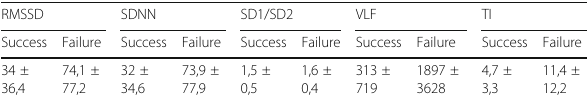
Table 1 (abstract 0143). HRV values in the different